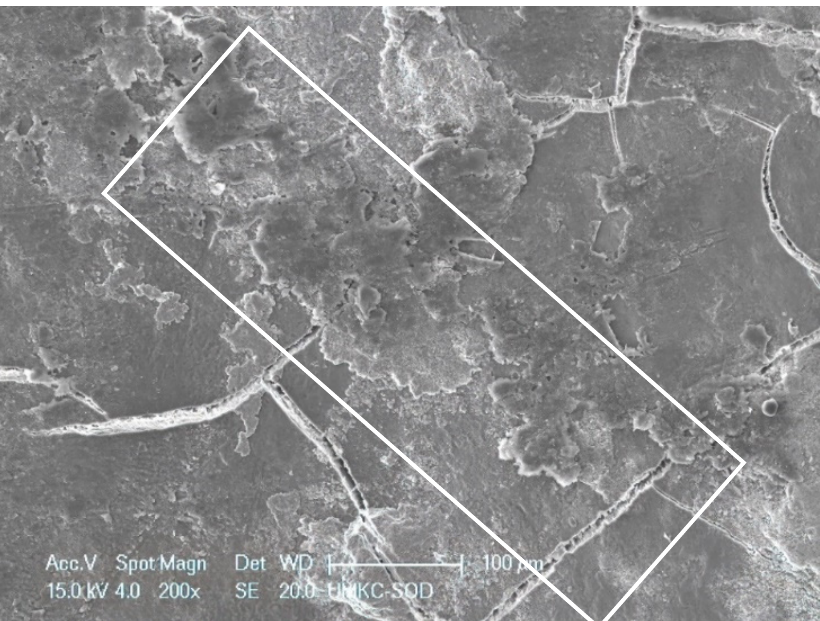
Figure 5. SRP + EDTA-treated specimen. Treated surface features a smearing or smudged appearance ( white rectangle ). Original magnification. 200×; Bar = 100 μ m.